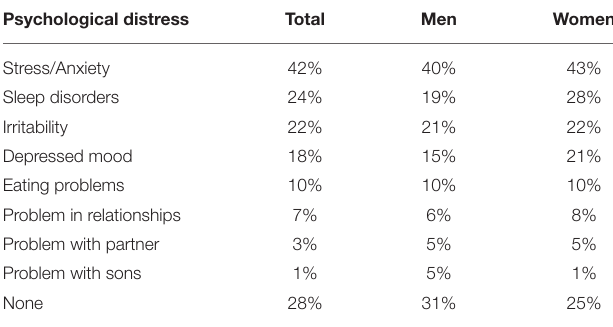
TABLE 2 | Main forms of psychological